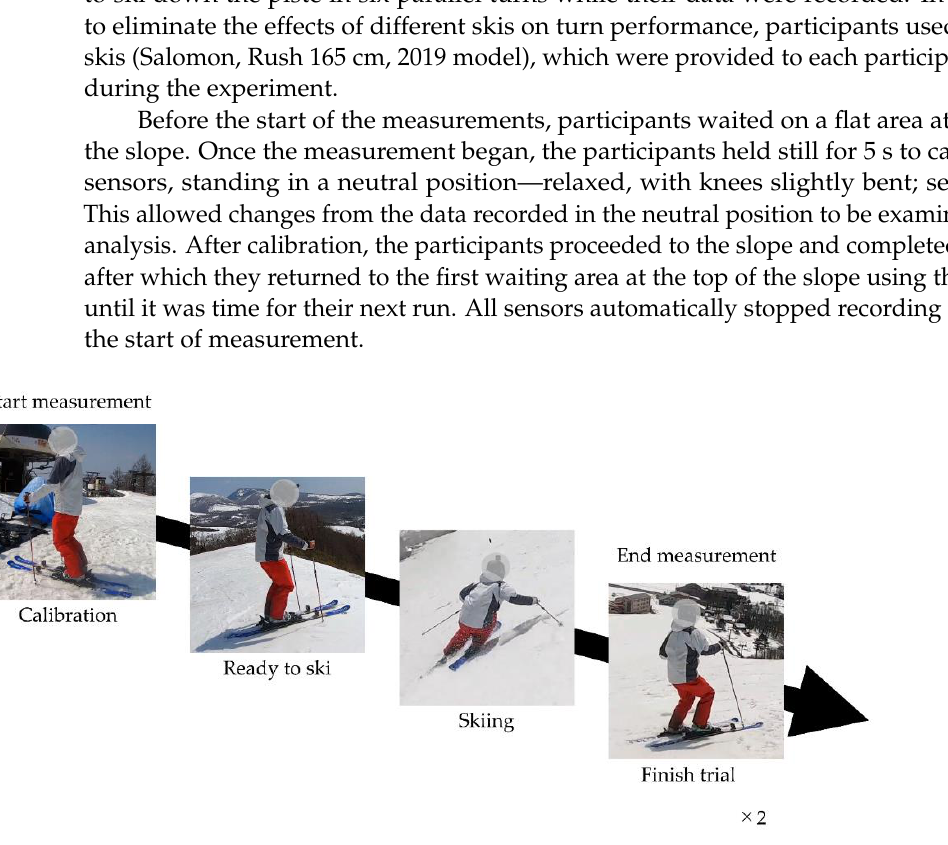
Figure 3. Experiment procedures. After the start of measurement, participants stood still for 5 s (for calibration) and then skied on the piste.